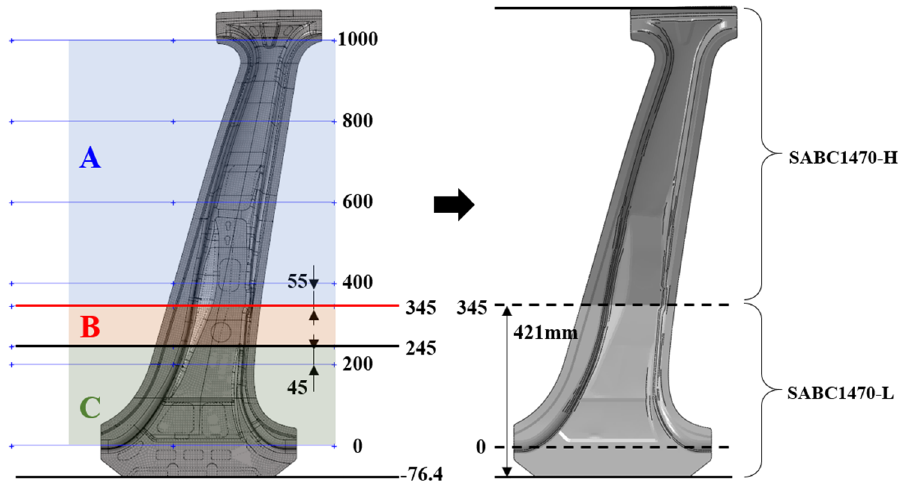
Figure 15. Components of center pillar with steel reinforcements. Table 3. Properties of center pillar with steel reinforcements.